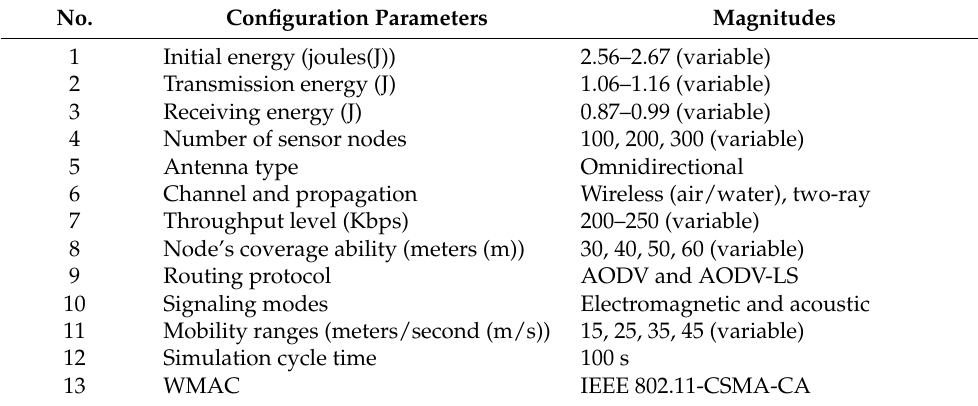
Table 6. The environment of